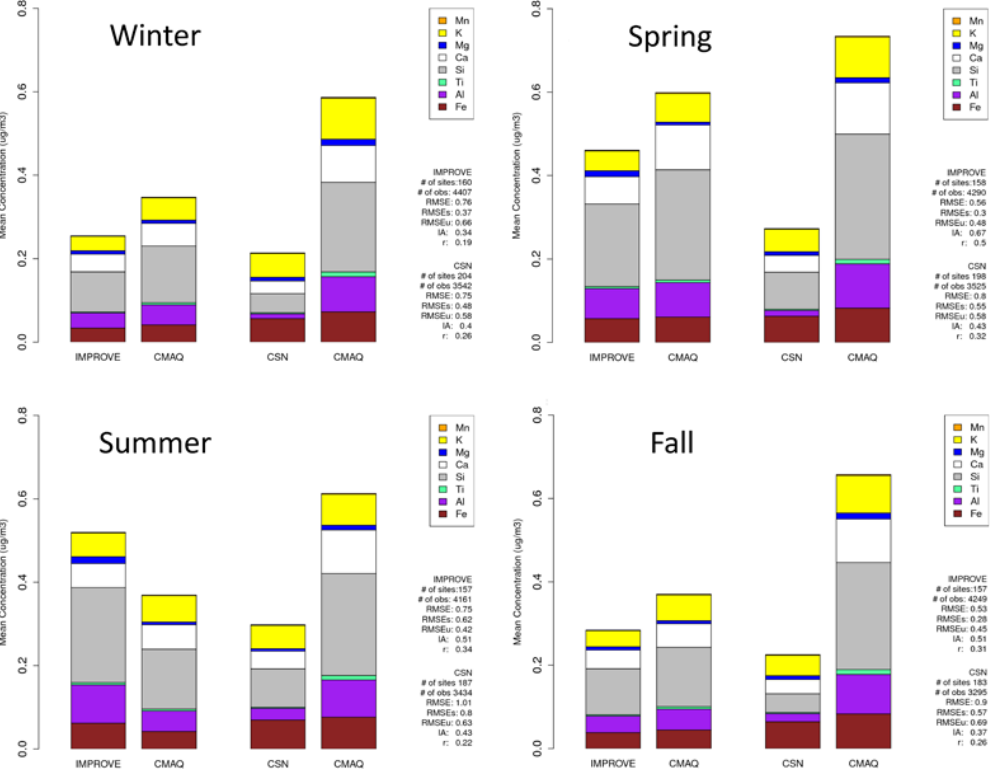
Fig. 3. Seasonal stacked bar plots of the observed concentrations (µgm − 3 ) of the fine particulate trace metals Fe, Al, Ti, Si, Ca, Mg, K, and Mn for the IMPROVE and CSN networks and the corresponding model-estimated concentrations. Shown below the legend on each plot are root-mean-square error (RMSE), index of agreement (IA), and correlation coefficient ( r ) for each